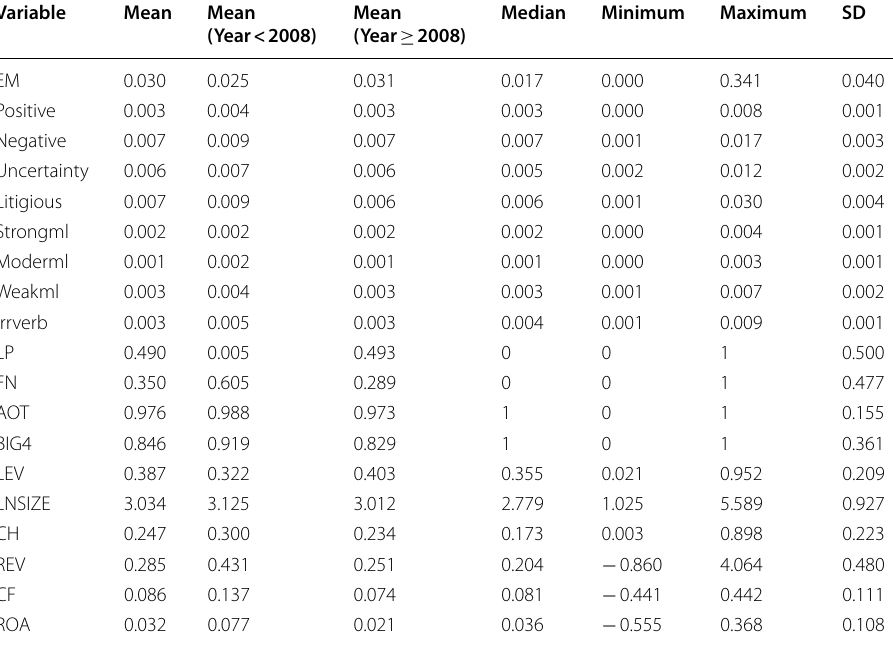
Table 1 Summary of descriptive